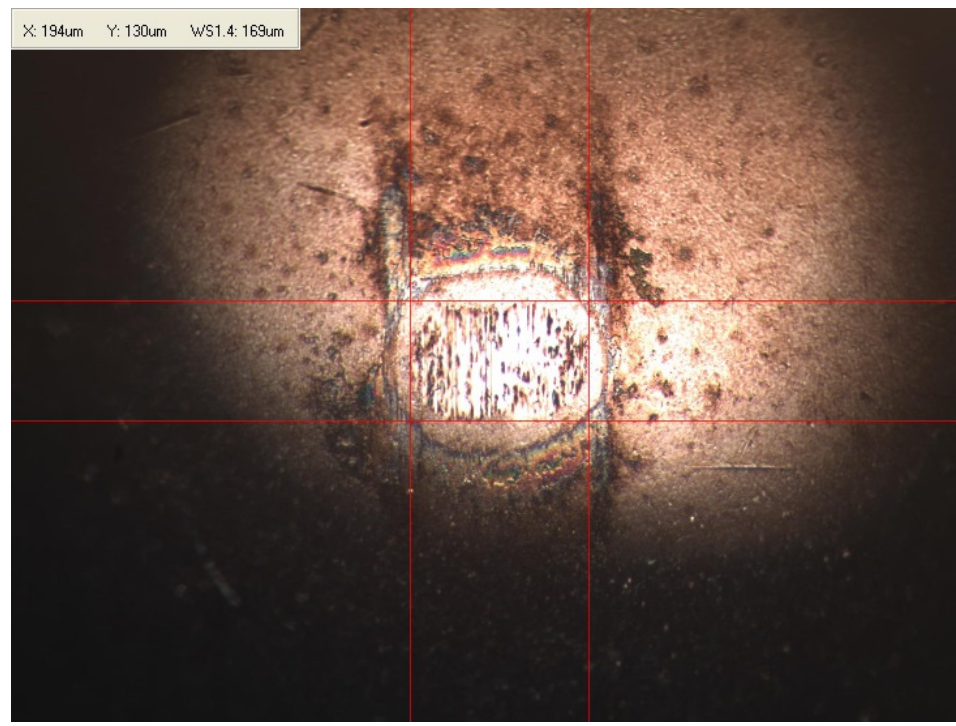
Figure A15. SAE 30/SAE 40—0%; DO—100%.